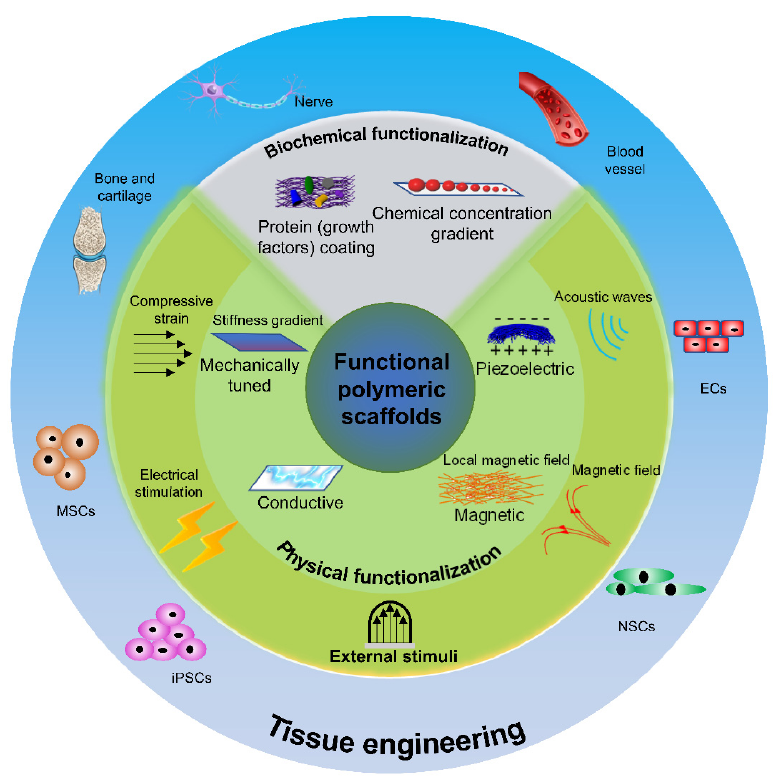
Figure 1. A schematic diagram of functional polymeric scaffolds and their applications in tissue and cell engineering. Abbreviations: endothelial cells (ECs), neural stem cells (NSCs), induced pluripotent stem cells (iPSCs), mesenchymal stem cells